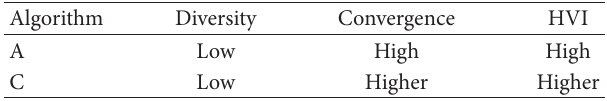
Table 3: Comparison of solution sets produced by Algorithms A and